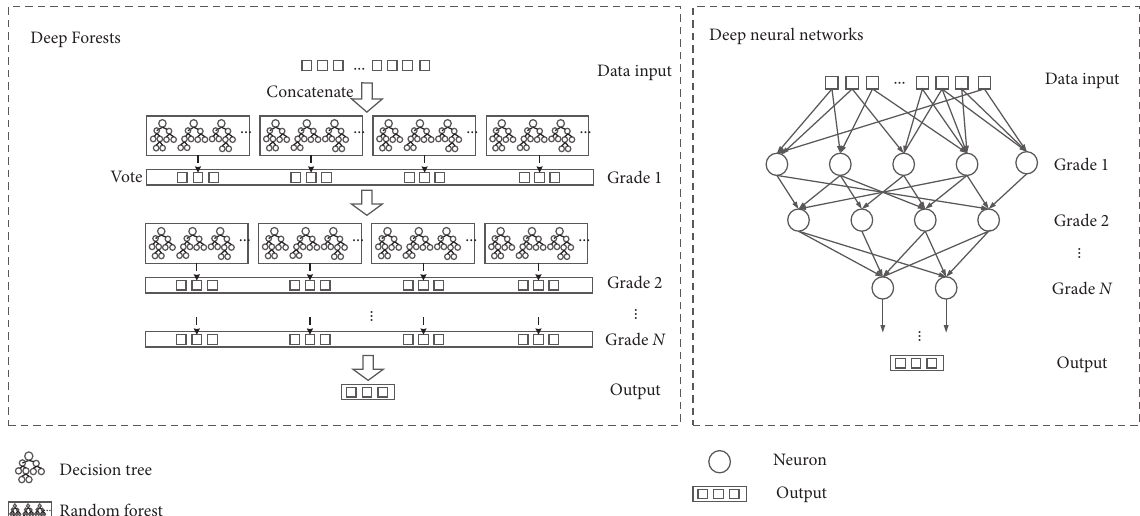
Figure 8: The cascade structure of Deep Forests and deep neural networks.